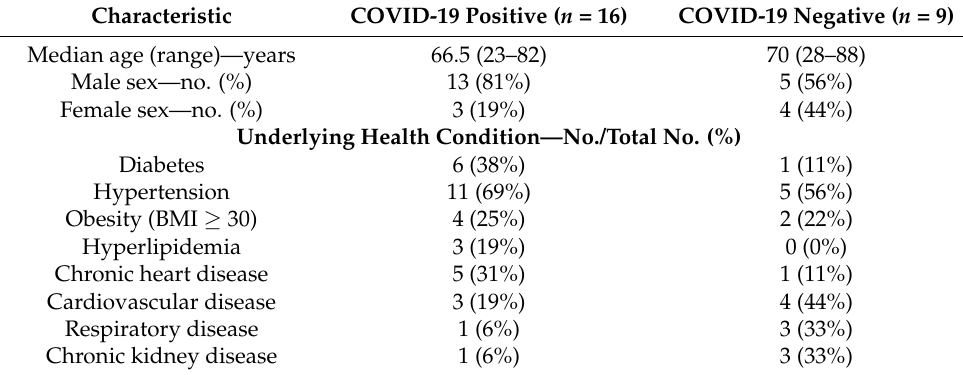
Table 1. Patient characteristics.